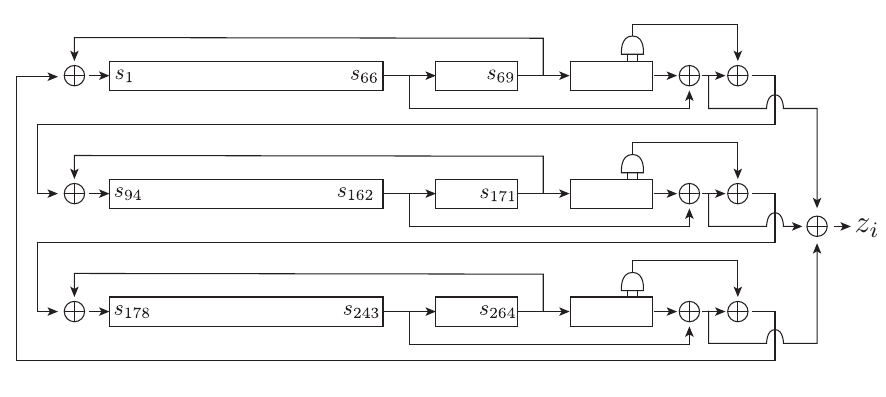
Fig. 3. Structure of Trivium Figure 1: Structure of